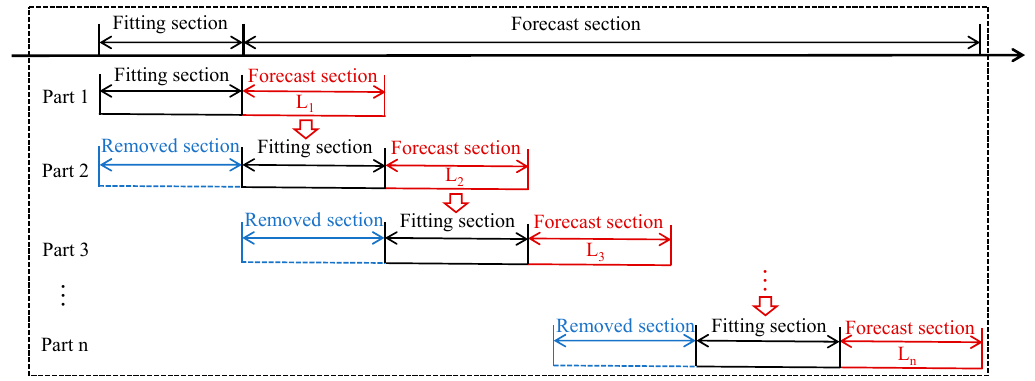
Figure 2. Prediction flow chart of the sliding window method.